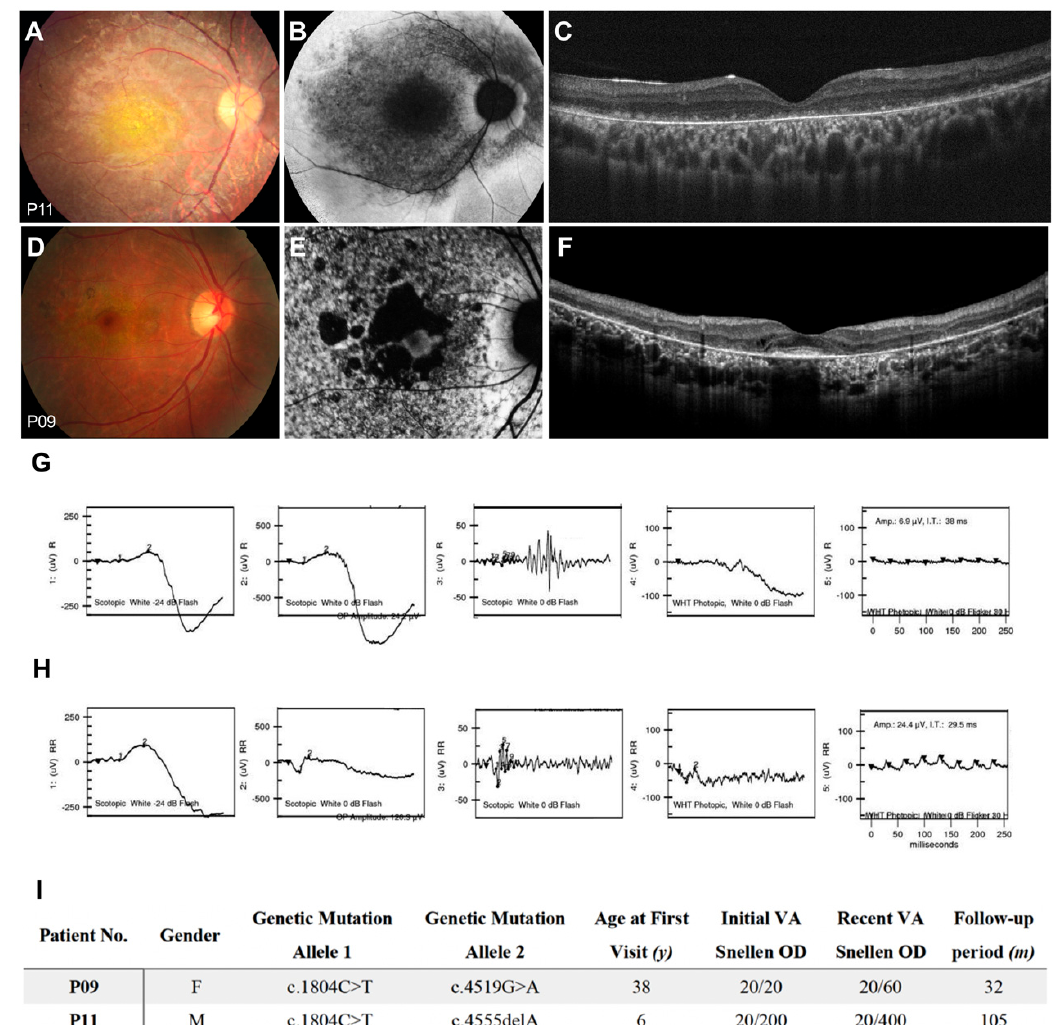
Figure 7. Clinical presentations of ABCA4 -associated cone-rod dystrophy. ( A ) P11 with macula depigmentation in fundus color, ( B ) DDAF lesions in the central macula, diffuse questionably decreased autofluorescence (QDAF) area extends to arcades, with the peripapillary area spared. ( C ) Diffuse loss of the ellipsoid zone and retinal pigment epithelium. ( D ) P09 with perifoveal depigmentation with a foveal sparing pattern. ( E ) Well demarcated perifoveal DDAF lesions surround the central foveal area with a heterogeneous background. ( F ) Diffuse loss of the ellipsoid zone and retinal pigment epithelium with preserved fovea. ( G ) Electroretinography of P11 showed a decreased amplitude of b waves in a scotopic environment with dim light, decreased b waves in a scotopic environment with bright light, decrease b / a ratio; nearly flat a, b waves in photopic environment, nearly flat waves in photopic flicker ( H ) Electroretinography of P09 with a decreased amplitude of b waves in a scotopic environment with dim light, decreased amplitude of a, b waves in a scotopic environment with bright light; decreased b wave amplitude in a photopic environment, and decreased amplitude in photopic flicker. ( I ) Clinical presentations of two patients with cone-rod dystrophy.